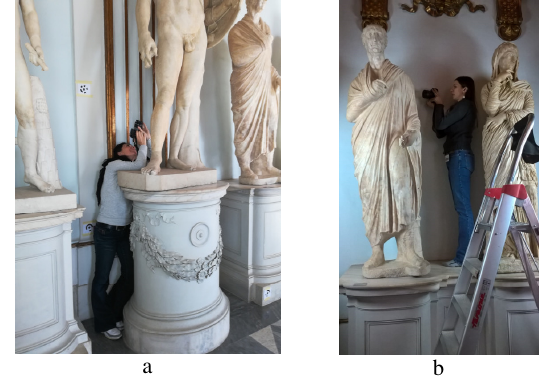
Figure 2. The difficulties in acquiring the images for the photogrammetric survey inside the rooms of the Museums.